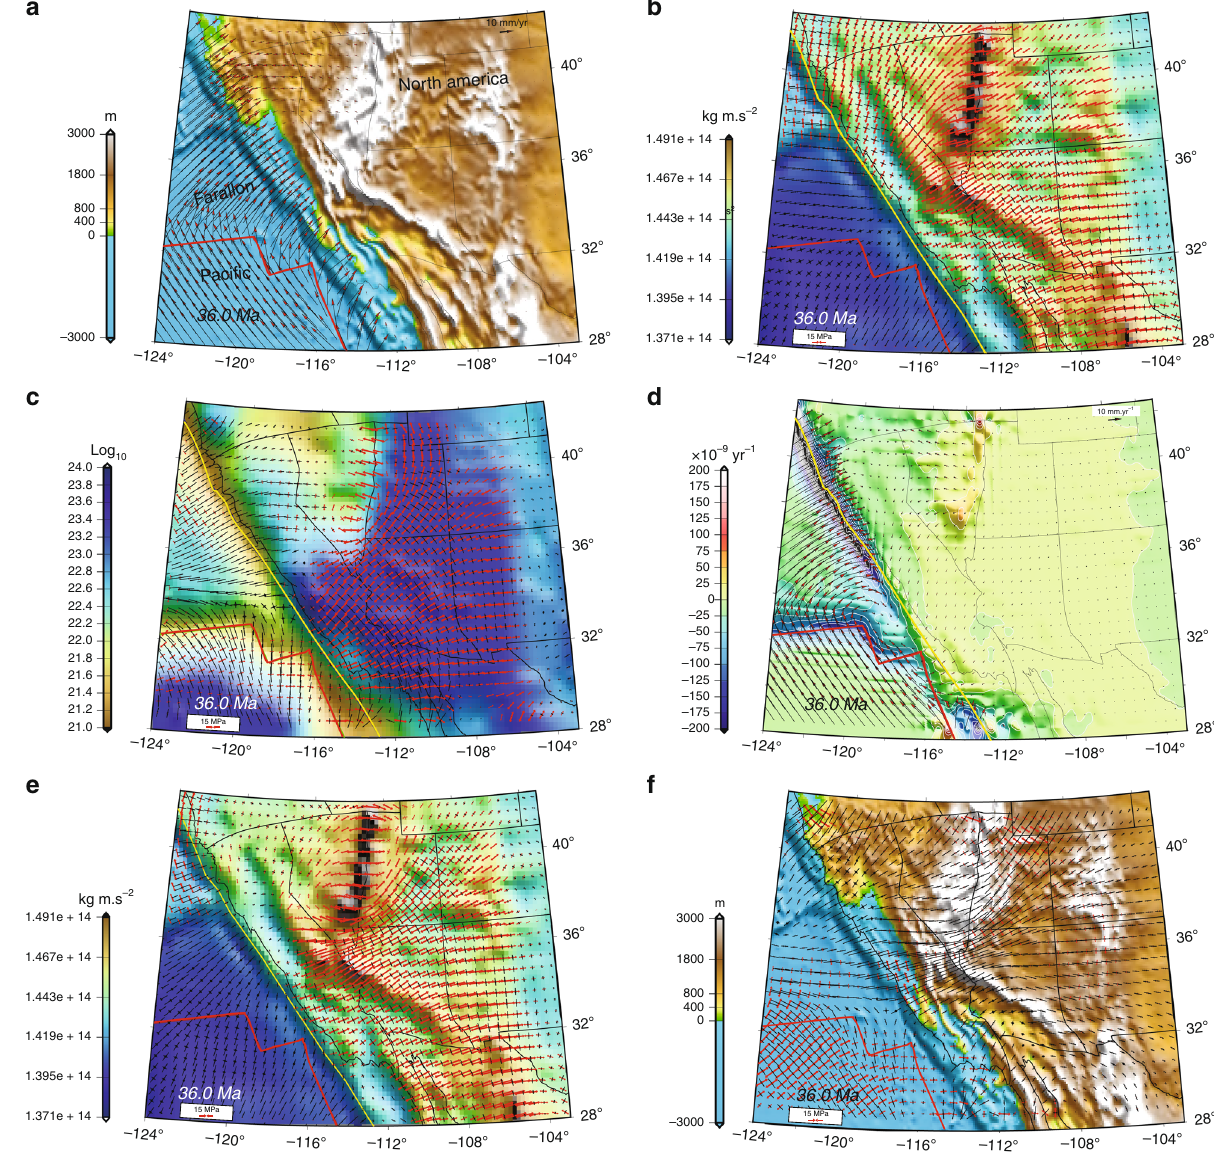
Fig. 4 Kinematics and dynamics of lithosphere in southwestern North America at Late Eocene. a Kinematic estimates based on land-based geological observations and also accommodation of Farallon- and Paci fi c-North America relative plate motions 6,7 in southwestern North America superimposed on paleo-elevation model of Bahadori et al. 8 . Red vectors represent model velocities relative to the North American frame. b Map of contoured GPE estimates. Arrows represent principal axes of vertically averaged horizontal deviatoric stresses associated with GPE gradients based on an initially constant viscosity value for the lithosphere. c Map of lithospheric effective viscosity and principal axes of deviatoric stresses obtained in fi nal iterative dynamic model. d Map of dilatational strain rates and model velocities relative to the North American frame achieved from iterative dynamic model. e Map of principal axes of deviatoric stress associated with GPE (contoured) gradients, obtained using fi nal estimates of laterally varying effective viscosity values in “ c ” . f Map of the stress fi eld boundary conditions obtained by subtracting stress values in “ e ” from stress values in “ c ” superimposed on paleo-elevation model of Bahadori et al. 8 . For all panels red arrows represent tensional, and black arrows represent compressional principal axes of deviatoric stress. Red line in all panels represents reconstructed position of the East Paci fi c Rise and SAFS. Yellow line in all panels represents reconstructed position of continental